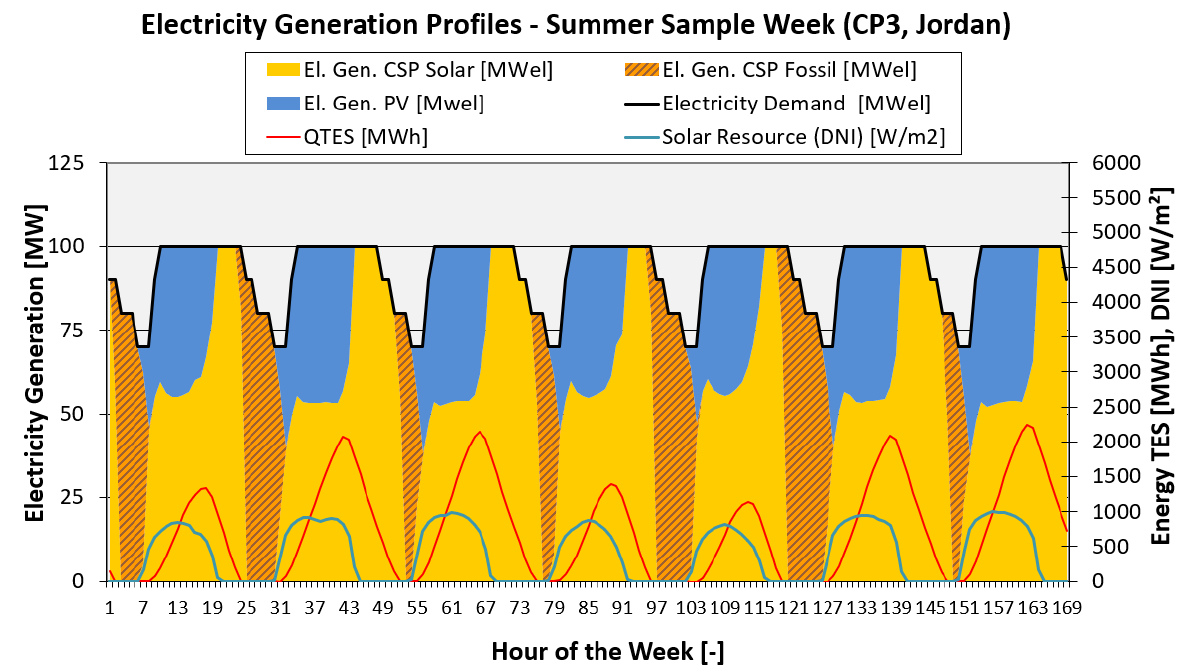
Figure 6. Weekly energy production example for Ma’an, Jordan .